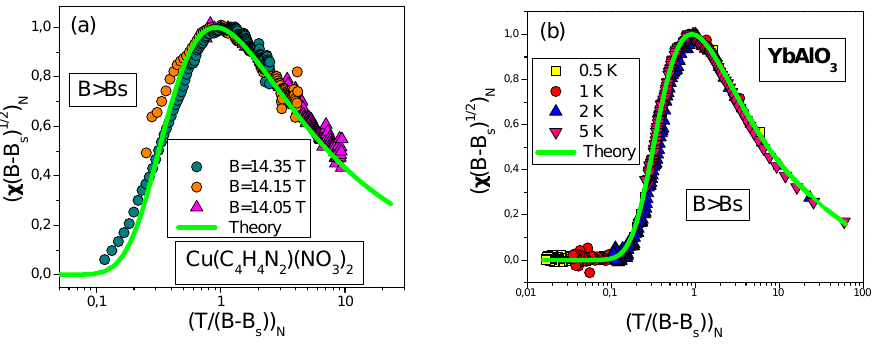
Figure 13. The normalized magnetic susceptibility χ N extracted from measurements in magnetic fields B > B s shown in the legend. Panel ( a ): χ N extracted from measurements on CuPzN [25]. Panel ( b ): χ N extracted from measurements on YbAlO 3 [24]. Our theoretical curves, plotted on the base of Equations (12) and (14), is taken from Figure 10b, and is reported by the solid line tracing the scaling behavior.